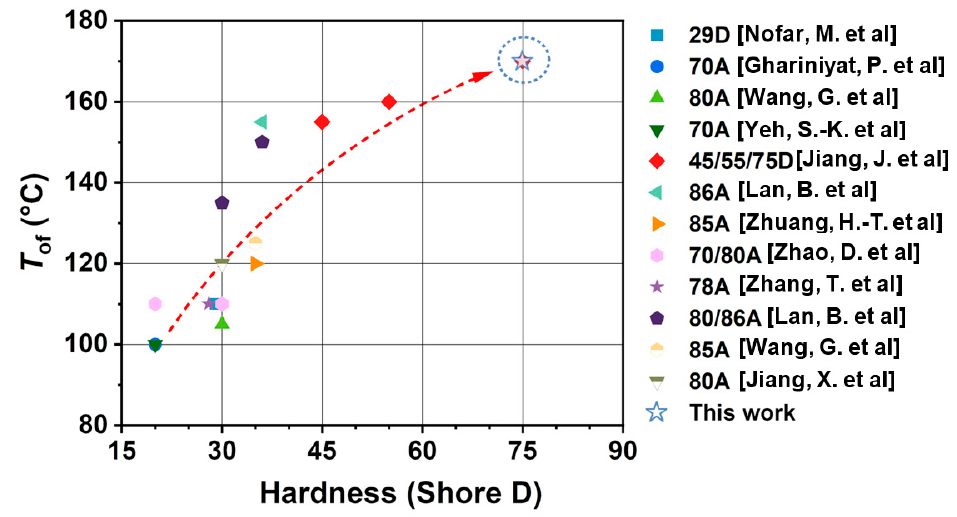
Figure 7. The relationship between hardness of resin and T of